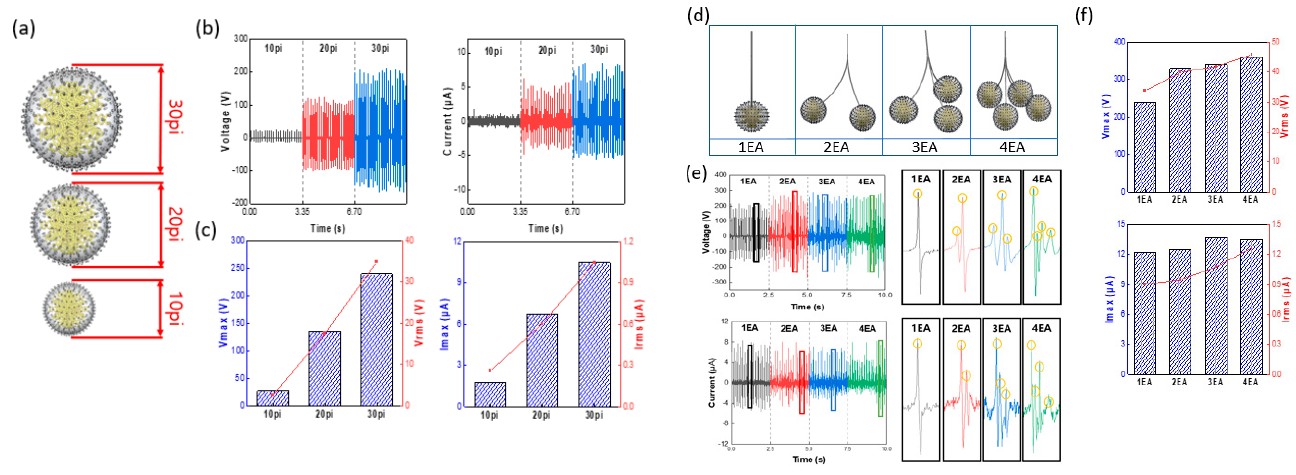
Figure 5. ( a ) Pictorial representation of various sizes of silicone rubber balls; ( b , c ) plots depicting V max , V rms , I max , and I rms according to size; ( d ) schematic showing a comparison of quantities of silicone rubber balls; and ( e , f ) plots of the voltage and current output waveform, and V max , V rms , I max , and I rms according to quantity.